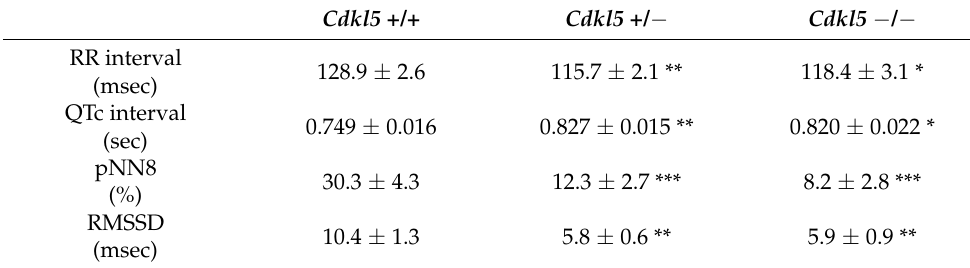
Table 1. Effect of genotype on ECG parameters. Mean heart period duration (RR); mean duration of ventricular depolarization and repolarization (interval between Q and T waves) after applying Hodge’s formula to consider potential differences in RR values between groups (QTc); percentage of RR values that differ from the following values by more than 8 ms (pNN8); root mean square of the successive RR differences (RMSSD). All these values were computed during non-rapid-eye- movement sleep in Cdkl5 +/+ (n = 8), Cdkl5 +/ − (n = 10) and Cdkl5 − / − (n = 8) female mice. Values are represented as mean ± SE. * p < 0.05 vs. Cdkl5 +/+, ** p < 0.01 vs. Cdkl5 +/+, *** p < 0.001 vs. Cdkl5 +/+ (Fisher’s LSD test after one-way ANOVA). Cdkl5 +/+ Cdkl5 +/ − Cdkl5 − / − RR